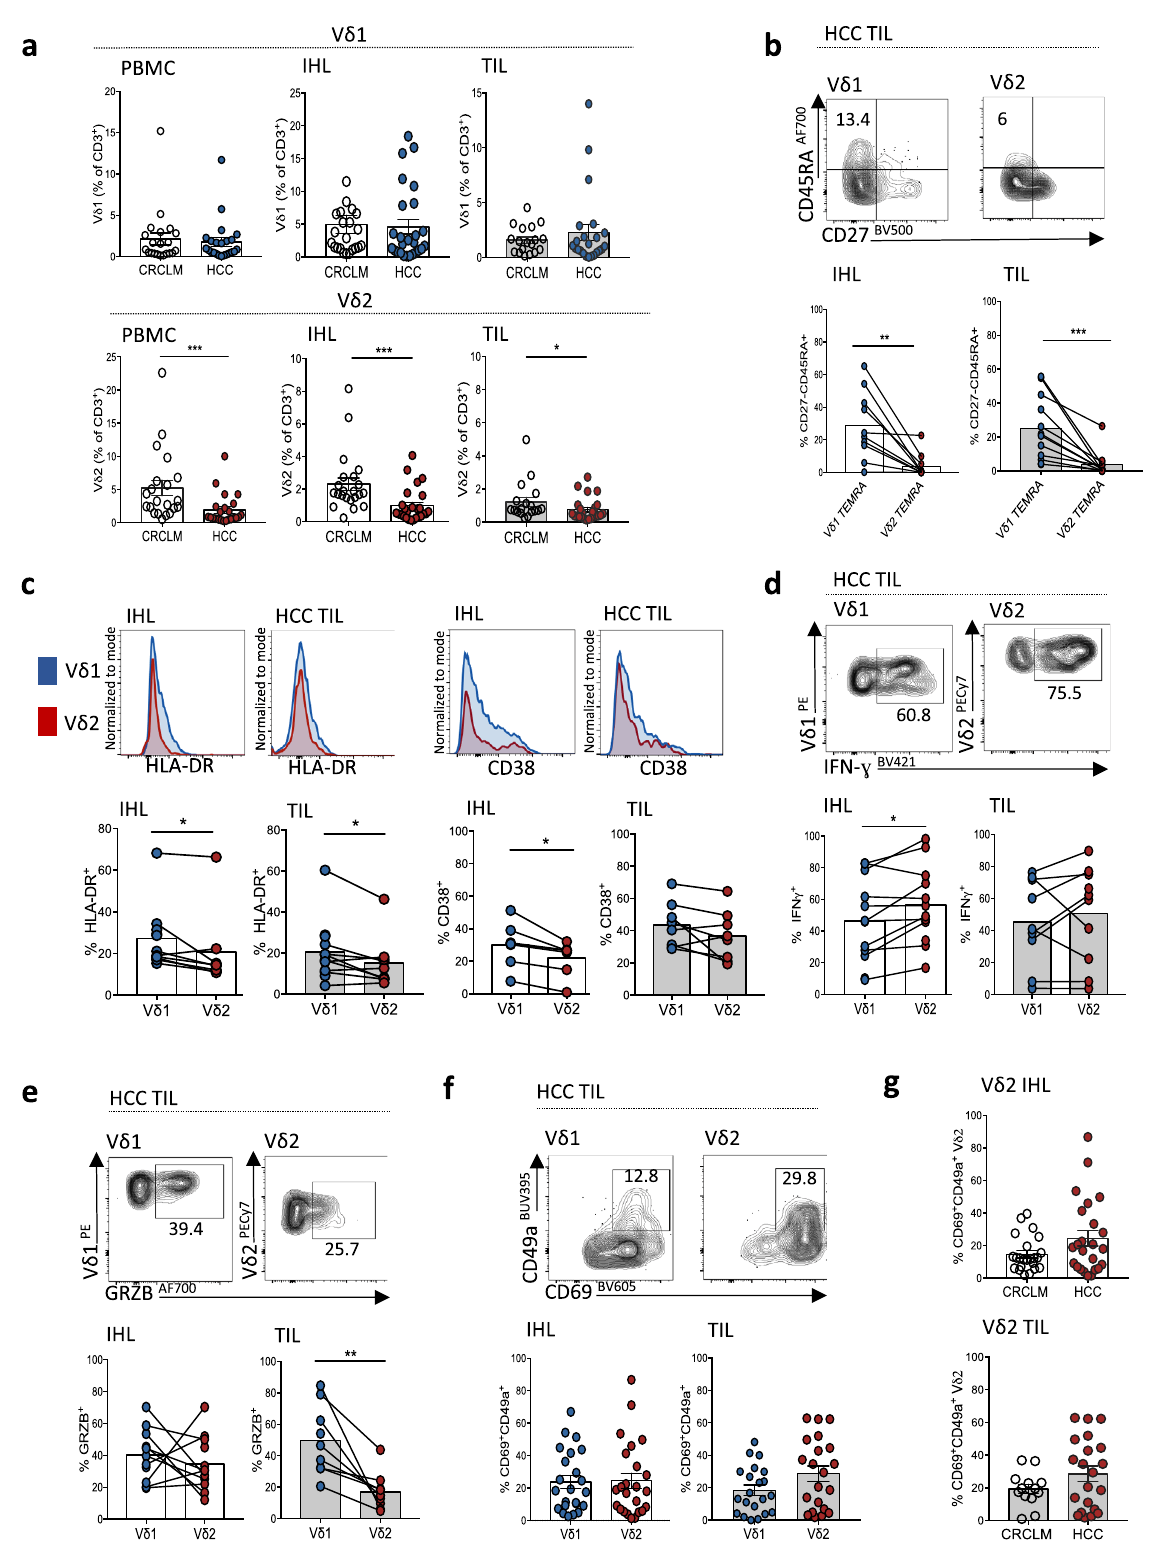
αβ CD8 + T-cell function (Supplementary Fig. 6b). To con fi rm that the increase in V γ 9V δ 2 T-cell effector function was depen- dent on tumour cell IPP expression, we additionally treated ZOL- exposed hepatoma cell lines with Mevastatin, an inhibitor of the mevalonate pathway, able to block tumour cell IPP production, prior to the co-culture with IHL (Fig. 6d) 51,54 . Mevastatin